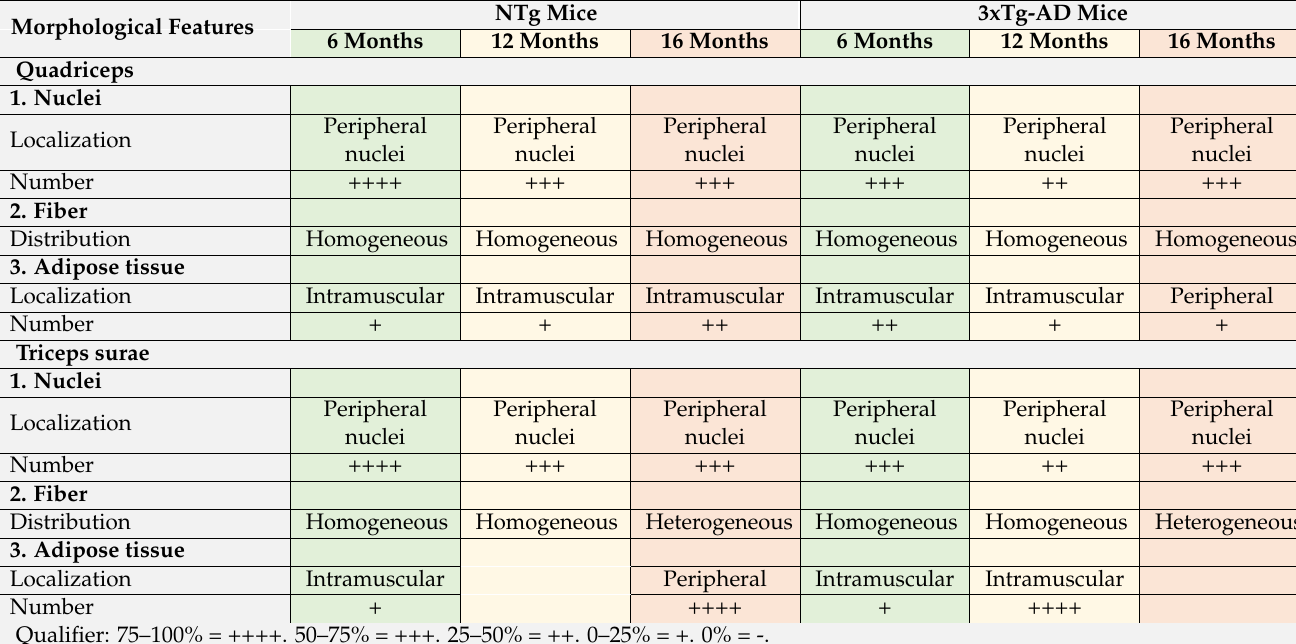
Table 2. Morphological features of muscle tissue in 3xTg-AD mice: localization and number of nuclei, fiber distribution, and a number and localization adipose cells. Qualitative quantifier of intensity: (-) equal to 0%, (+) less to 25%, (++) less to 50%, (+++) less to 75%, and (++++) less or